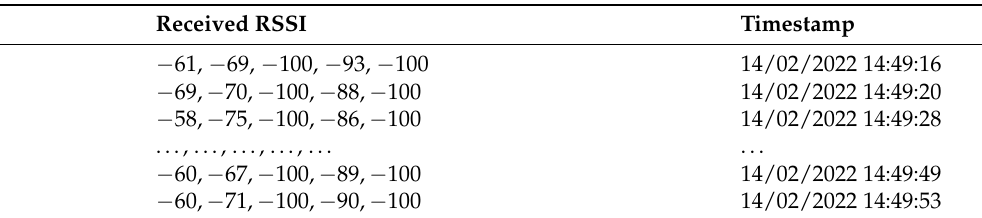
Figure 11. Block diagram of the ML approach followed in this project (taken from [24]). Table 4. Example of a sample of the RSSI values of the broadcast packets received by all stations for a defined period of time for location (6,2). Data from